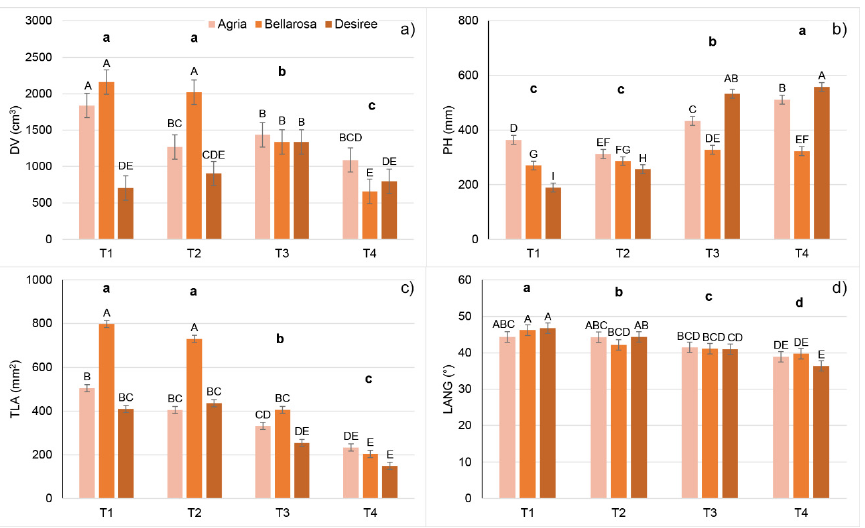
Figure 1. Mean values and double standard error of the mean for the morphological traits: ( a ) digital volume (DV), ( b ) plant height (PH), ( c ) total leaf area (TLA), and ( d ) leaf angle (LANG) of potato cultivars (Agria, Bellarosa, and Desiree) after ten days of growth in four different temperature treat- ments: 20/15 °C (T1), 25/20 °C (T2), 30/25 °C (T3), and 35/30 °C (T4). Different uppercase letters indicate significant differences for cultivar × treatment interaction; different lowercase letters in bold indicate significant differences between temperature treatments (Tukey’s HSD test p < 0.05).